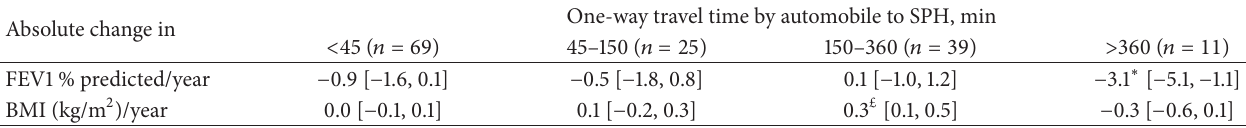
Table 3: Longitudinal analysis of rates of absolute change in FEV1% predicted and BMI by travel time. Absolute change